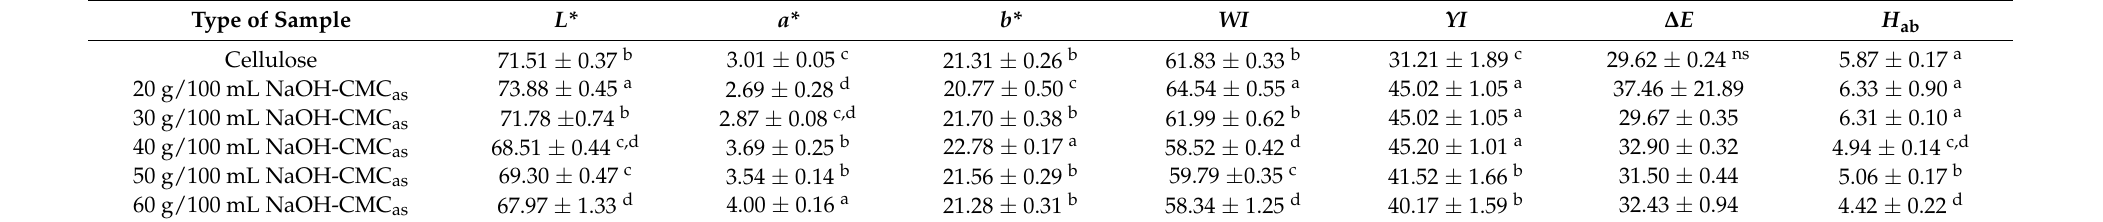
Table 1. Color values of cellulose and CMC as synthesized with various NaOH